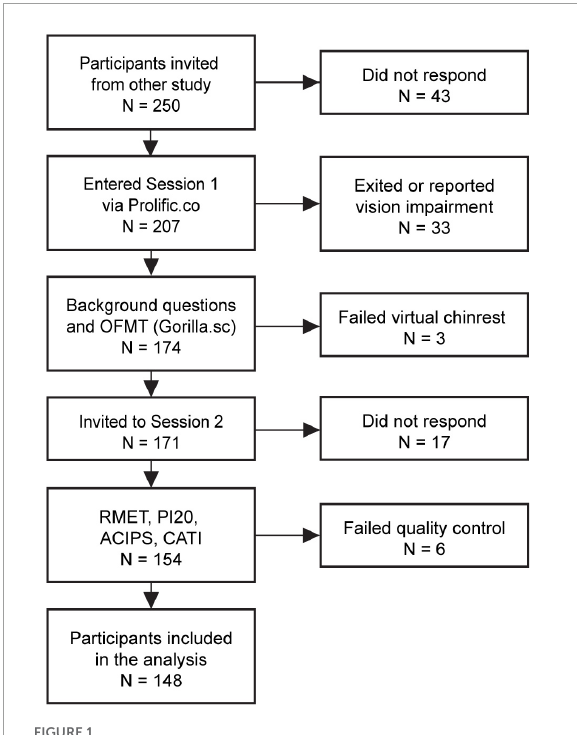
FIGURE1 Illustration of the experiment flow and reasons for attrition or exclusion. Invitation of participants consisted of advertising a study on Prolific with a built-in visibility filter that was based on participation in a different experiment; thus, no interactions occurred between researchers and participants at this step. See section “Materials and methods” for quality control criteria for tasks and questionnaires. ACIPS, Anticipatory and Consummatory Interpersonal Pleasure Scale; OFMT, Oxford Face Matching Task; PI20, 20-item Prosopagnosia Index; RMET, Reading the Mind in the Eyes